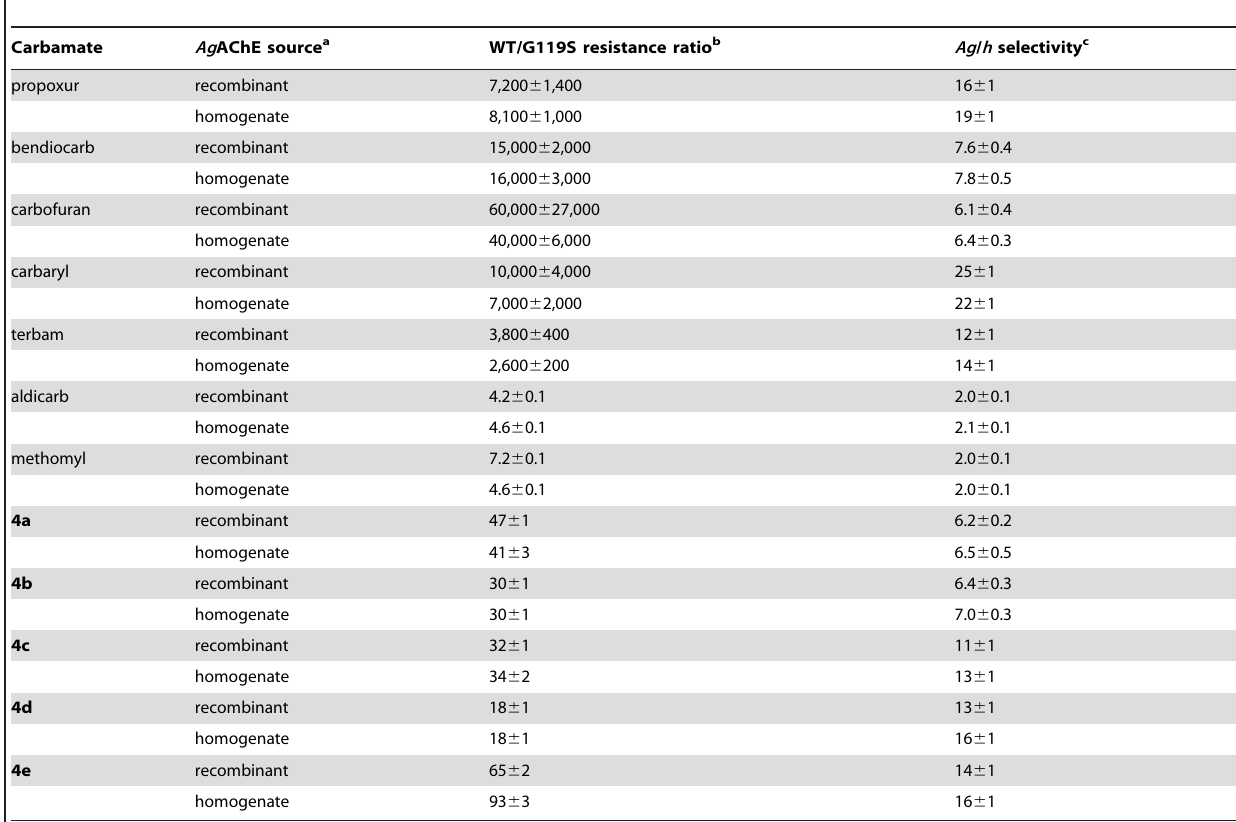
Table 3. Enzyme resistance ratios and Ag AChE vs h AChE selectivity of selected carbamates.